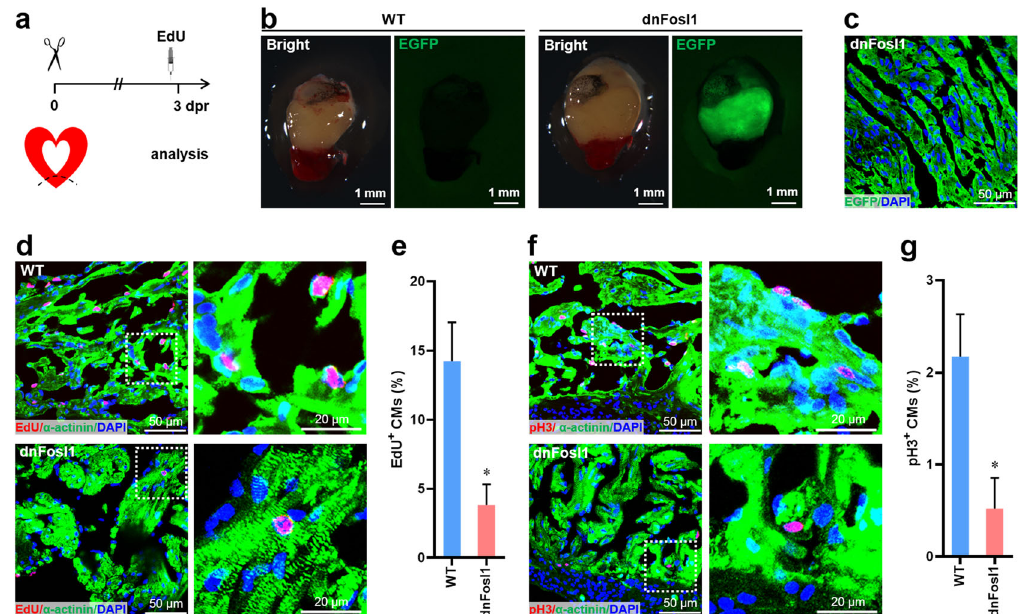
Fig. 8 Fosl1 function is required for cardiomyocyte proliferation during X. tropicalis heart regeneration. a Schematic of heart injury and sample collection in adult X. tropicalis . b Whole images of hearts isolated from wild-type (WT) and Tg(Mlc2-dnFosl1-T2A-EGFP) line at 3 dpr. c Validation of EGFP expression in the ventricular section from the dnFosl1 heart. d , e Representative images ( d ) and quanti fi cation ( e ) of EdU + cardiomyocytes in the ventricle apex following EdU injection at 3 dpr ( n = 5 hearts per group). Right panel of d is the magni fi ed confocal images of EdU + cardiomyocytes. f , g Representative images ( f ) and quanti fi cation ( g ) of pH3 + cardiomyocytes are shown in the ventricle apex ( n = 5 hearts per group). Magni fi ed representative confocal images of pH3 + cardiomyocytes are shown in right panel of f . All data are presented as mean ± SEM. * p < 0.05 versus WT (Student ’ s t